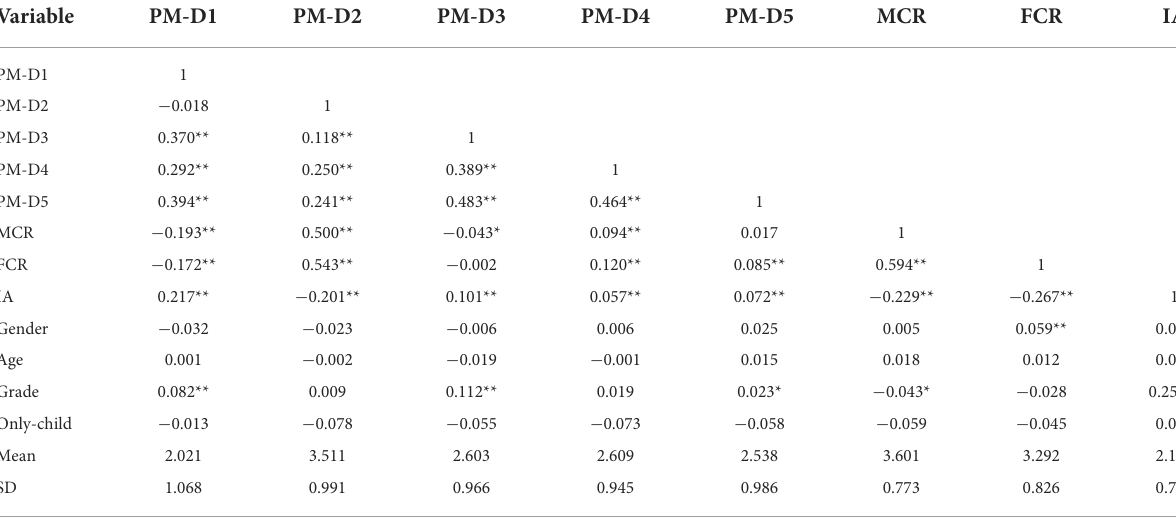
TABLE 1 Descriptive statistics and correlations for all variables ( N = 3,026).